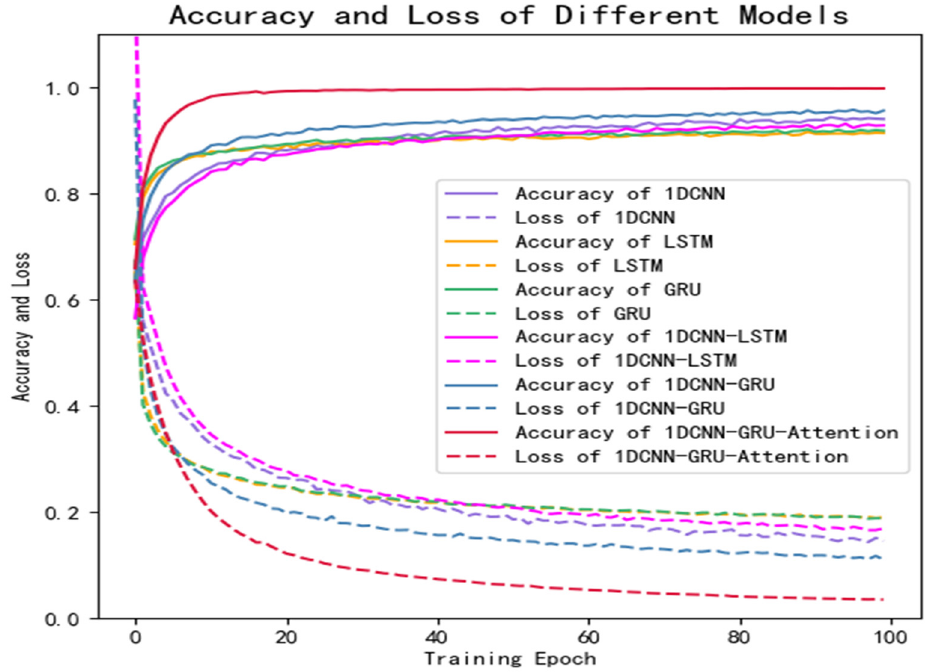
Figure 11. Results of comparative experiments on private dataset.